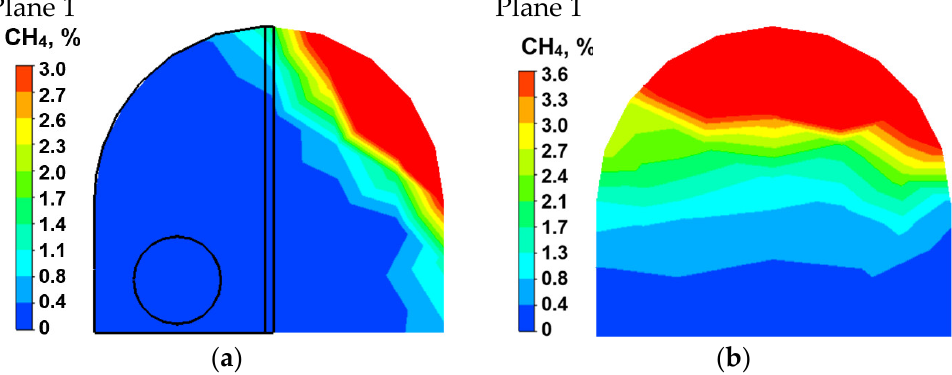
Figure 10. The distributions of methane concentrations in selected vertical sections (Plane 1) of the tailgate with built-in AVE ( a ) and without such equipment ( b ).